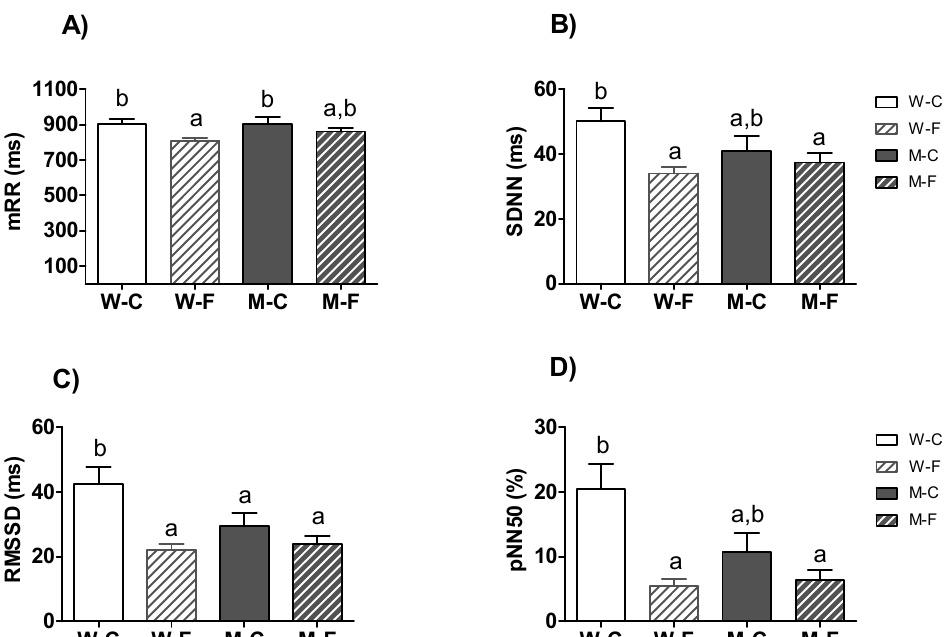
Figure 3. Comparison of the HRV time-domain indices in the whole sample. Mean ± SEM of ( A ) mean of RR intervals (meanRR), ( B ) standard deviation of all RR intervals (SDNN), ( C ) root mean square of differences of successive RR intervals (RMSSD), and ( D ) the proportion derived by dividing the number of interval differences of successive RR intervals greater than 50 ms by the total number of RR intervals (pNN50). a,b Mean values with unlike letters were significantly different between groups (two-way ANOVA and Duncan’s post hoc comparison, p < 0.05). W-C: Healthy control women ( n = 25); W-F: ME/CFS women ( n = 44); M-C: Healthy control men ( n = 18); M-F: ME/CFS men ( n = 32).